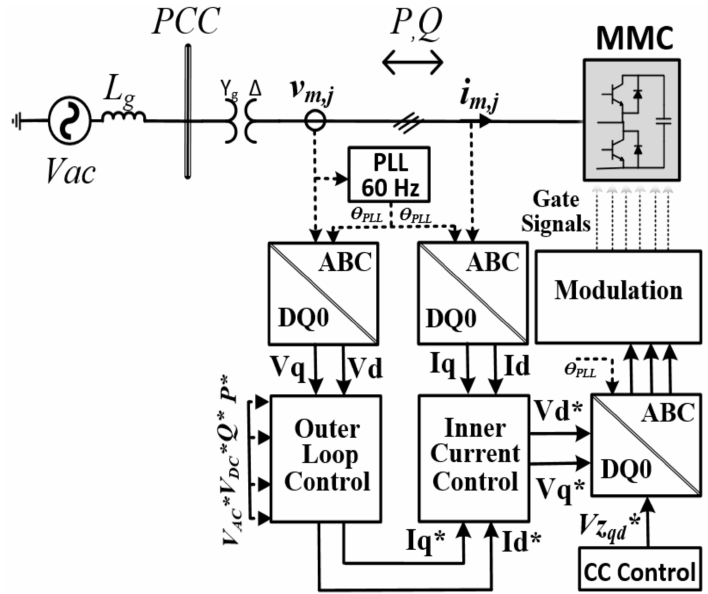
Figure 3. Overview of MMC control